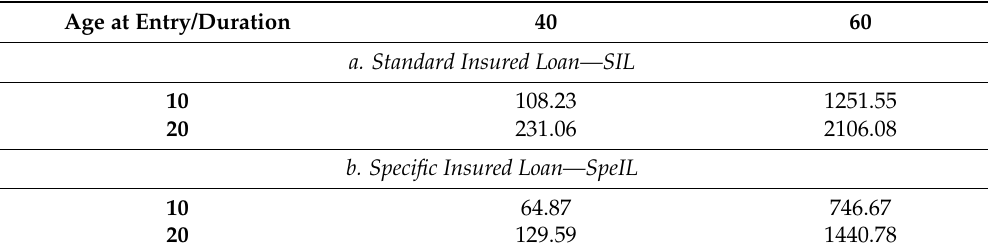
Table 4. Actuarial periodic premium—male. Issue time 2014, r = 2%, i = 7%, C = 200,000.